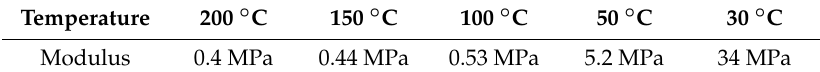
Table 3. Storage modulus of acrylic adhesive during cooling process.